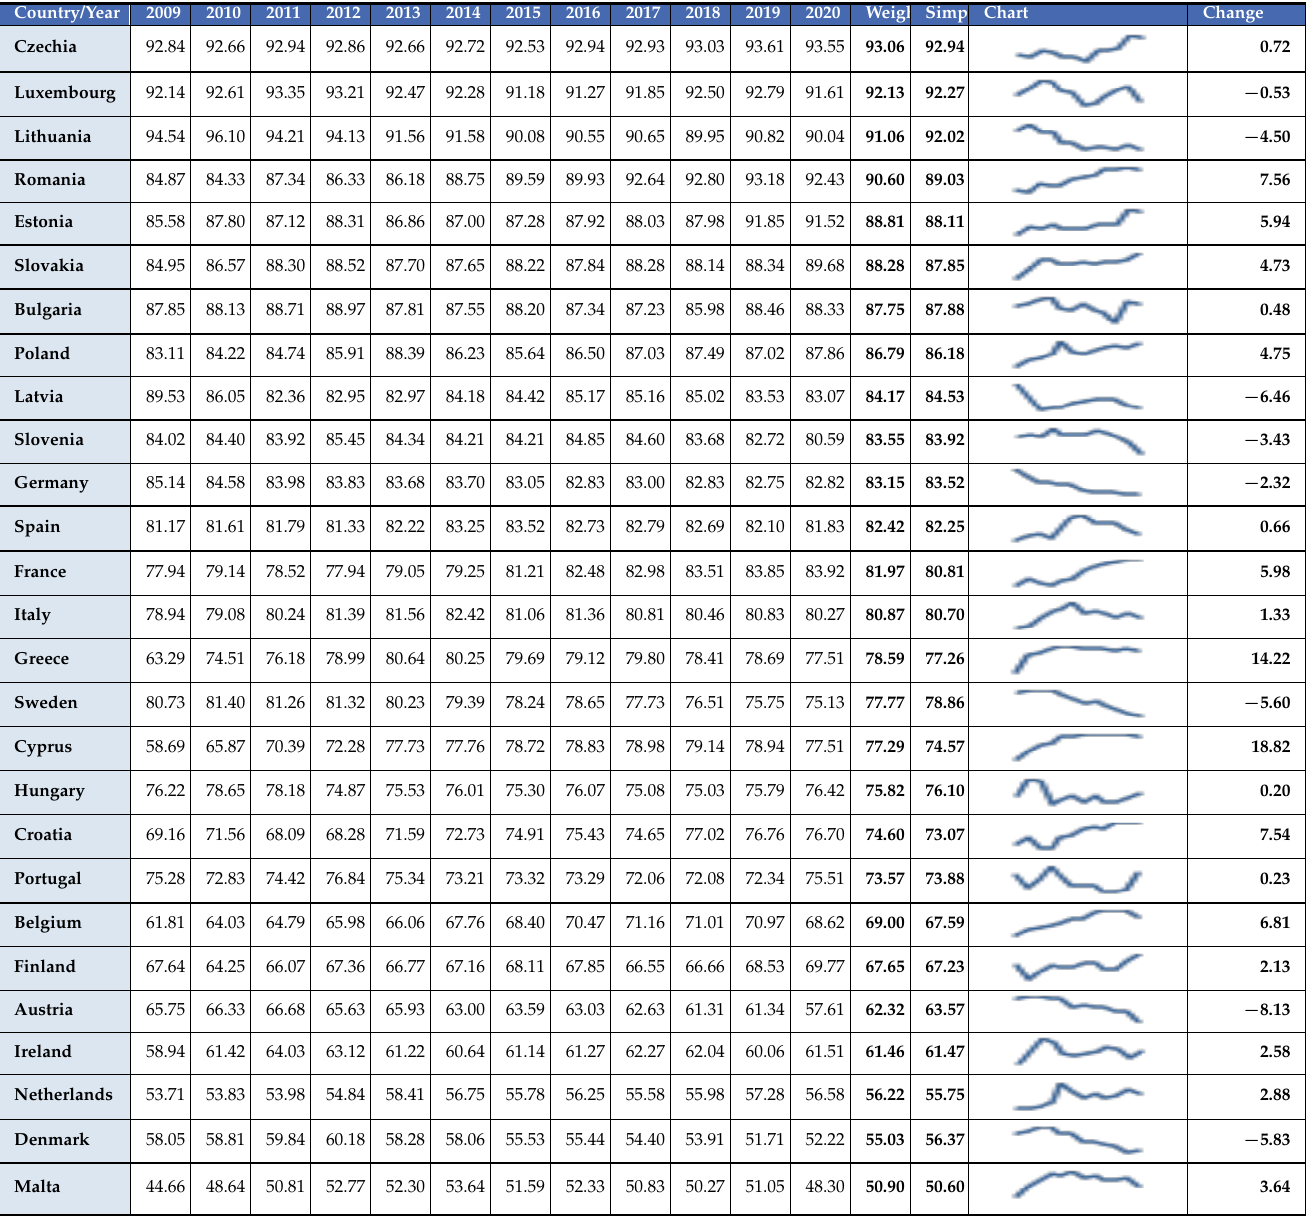
Table 3. Ranking of the EU27 based on the criterion of the weighted average level of the share of energy tax revenues in environmental tax revenues in 2009 – 2020 (source: own study).